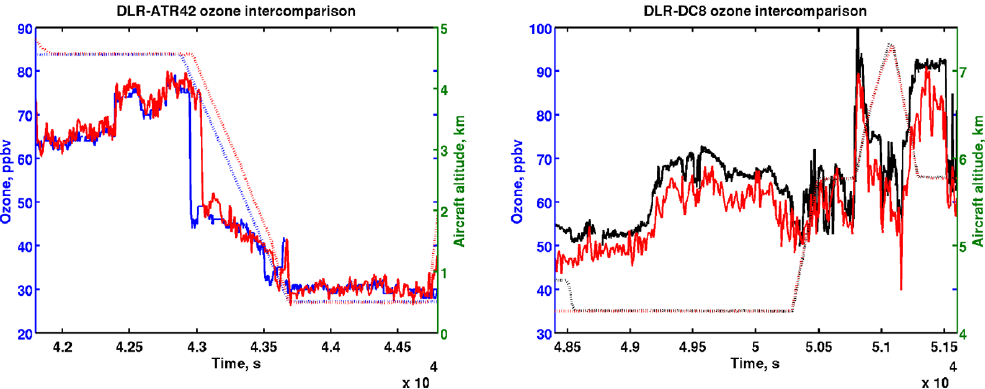
Figure 2. Intercomparison of O 3 measurements in ppbv (solid line and left vertical scale) during two wing tip-to-wing tip flights over Greenland between the ATR-42 (blue) and the DLR Falcon-20 (red) on 14 July (left panel) and between the NASA-DC-8 (black) and the DLR Falcon-20 (red) on 9 July (right panel). The aircraft altitude changes are in km (dotted line and right vertical